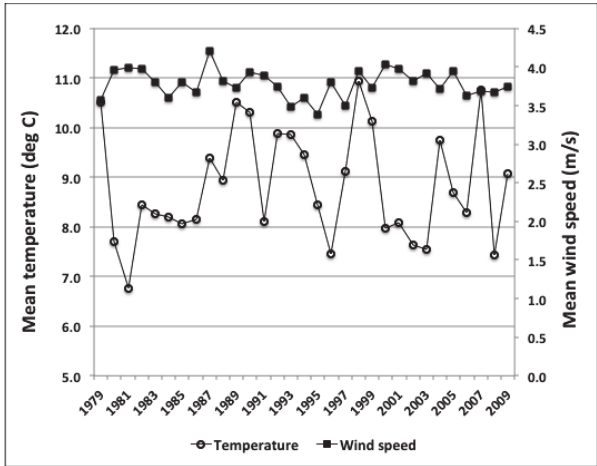
Fig. 3. Mean temperature and mean wind speed for the pe- riod 1 June to 31 August for the study region